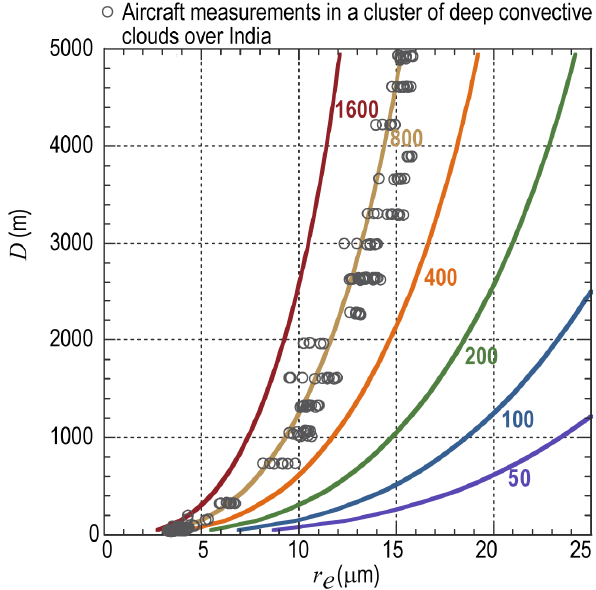
Fig. 3. Relationship between r e and D for various values of N a in cm − 3 . The value derived from the profile of r e measured by the aircraft is N a =610 cm − 3 (580mg − 1 ), within 5% of the directly aircraft-measured maximum cloud base droplet